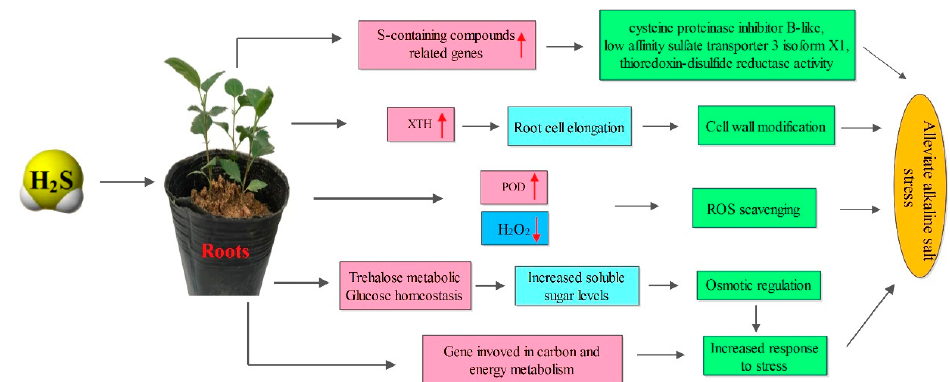
Figure 9. A model for the mechanisms underlying the hydrogen-sulfide-enhanced alkaline salt tolerance of Malus hupehensis Rehd. Hydrogen sulfide alleviates alkaline salt stress due to the activation of multifaceted defense machinery in the roots. In the roots, cell wall elongation increases because XTH gene expression is upregulated, and with the increase of POD gene expression, ROS scavenging ability was enhanced, thereby, effectively achieving osmotic regulation and detoxification of ROS.